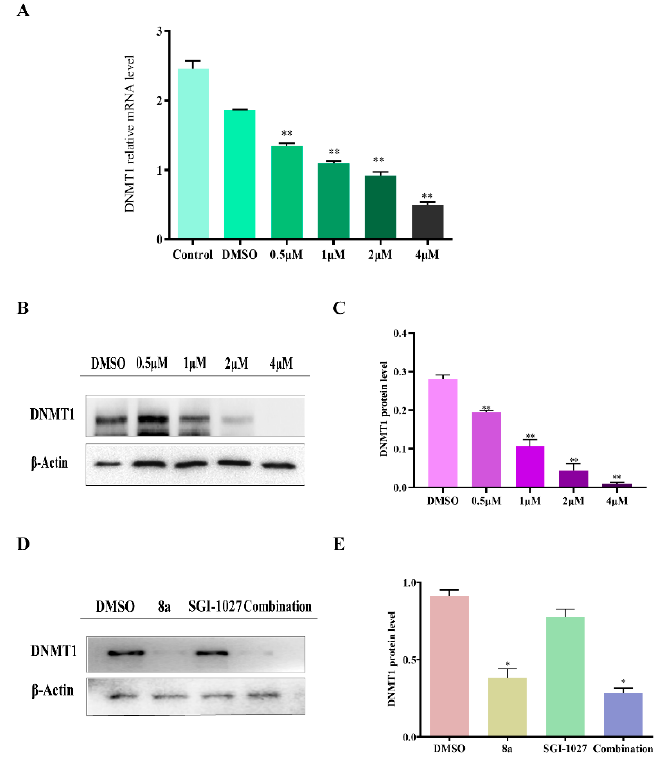
Figure 7. 8a affected the expression of DNMT1. ( A ) RT-PCR was used to analyze the mRNA expression of DNMT1 under different concentrations of 8a (0.5, 1, 2, and 4 μ M) in U937 cells (** p < 0.01); 0.1% DMSO can be used to eliminate the interference of compound solvents. ( B , C ) Western blots analysis of whole-cell extracts from cells treated with 8a (0.5, 1, 2, and 4 μ M) for 48 h (** p < 0.01); 0.1% DMSO was used as the control. ( D , E ) Western blots analysis of U937 cells treated with 8a (2 µ M) and SGI-1027 (3 µ M) for 48 h. Whole-cell extracts from cells exposed to 0.1% DMSO was used as the control (* p < 0.05, ** p < 0.01).